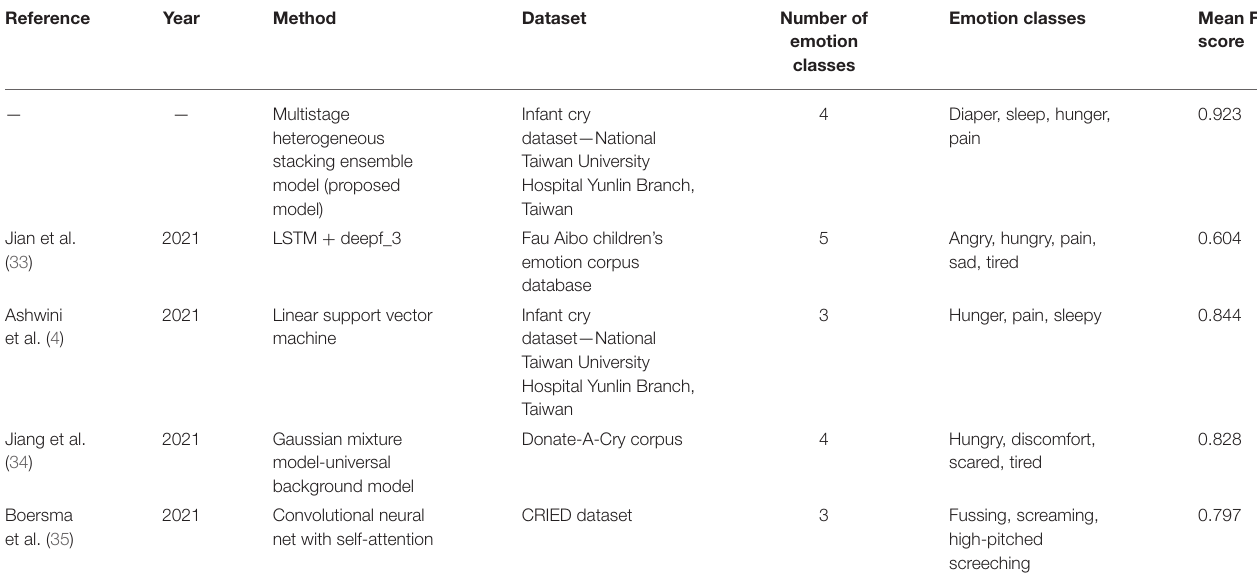
TABLE 16 | Comparison with the state-of-the-art models.